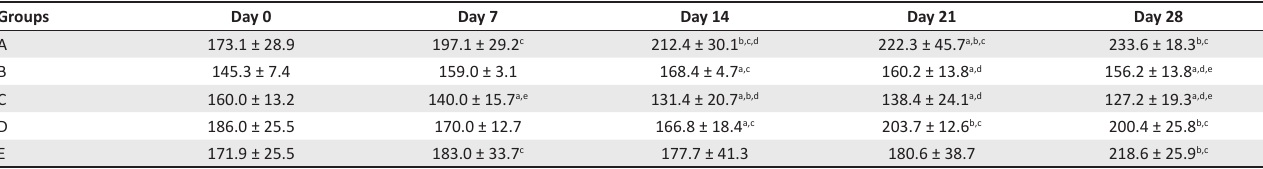
TABLE 2: Effects of Vernonia amygdalina on body weight (g) of alloxan-induced diabetic rats. Groups